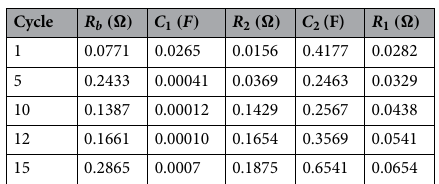
Table 3. Variation of system parameters